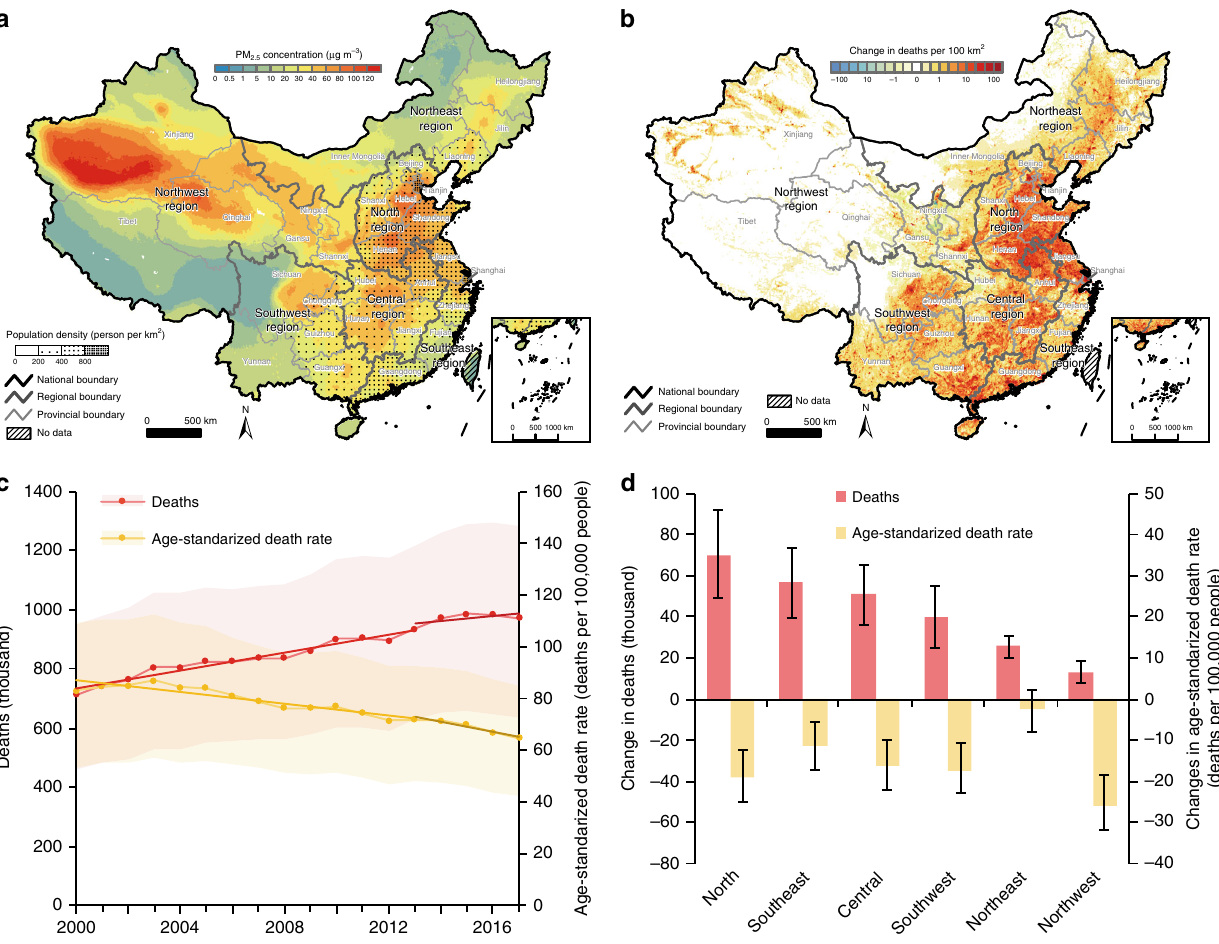
Fig. 2 Changes in the deaths attributable to PM 2.5 pollution (DAPP) and corresponding age ‐ standardized death rate in China. a China ’ s PM 2.5 concentration and population density (averages from 2000 to 2017). b spatial change in the DAPP between 2000 and 2017. c the dynamics of the DAPP and corresponding age ‐ standardized death rate for China. d regional changes in the DAPP and corresponding age ‐ standardized death rate between 2000 and 2017. Shade and error bars refer to the 90% con fi dence intervals. Source data are provided as a Source Data fi le. Table 1 Region ‐ speci fi c and disease ‐ speci fi c changes in the deaths and corresponding age ‐ standardized death rate attributable to PM 2.5